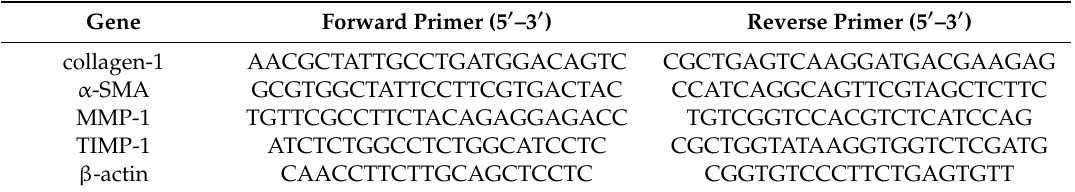
Table 4. The primer sequences used for real-time PCR